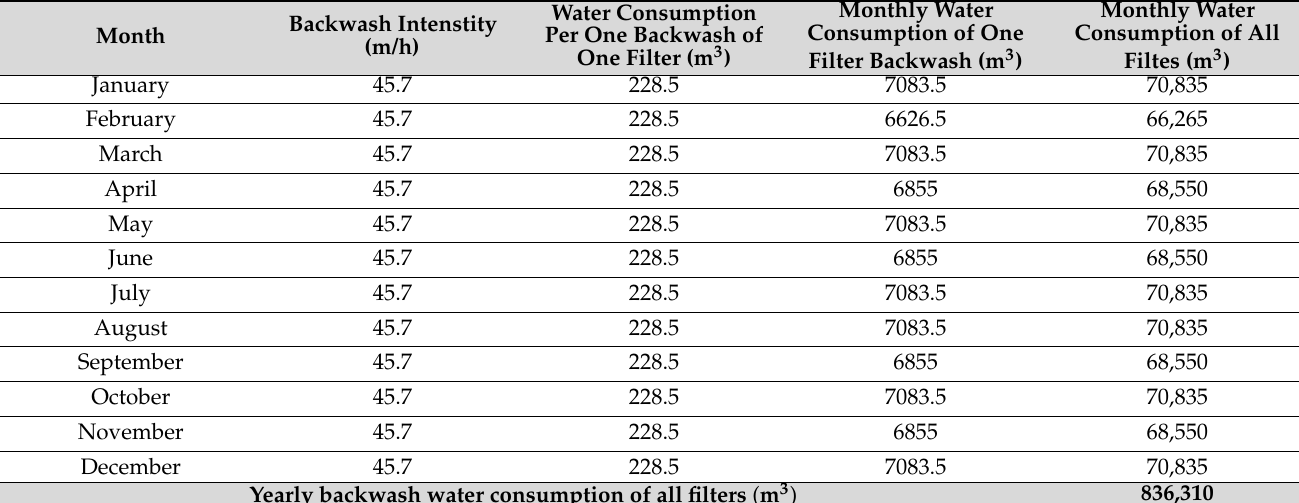
Table 4. Amount of water used for backwash of rapid filters without monthly backwash intensity